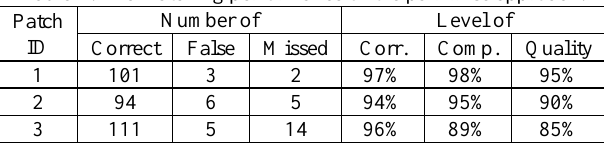
Table 1. The matching performance of the pair-wise approach.